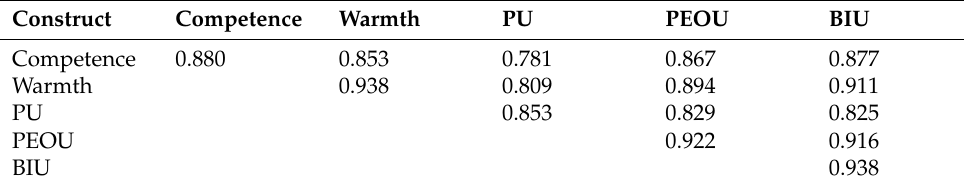
Table 3. Fornell–Larcker test of discriminant